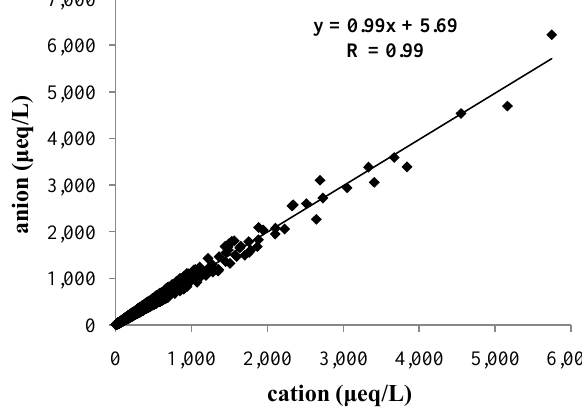
Fig. 3. Relationships between the sum of cations and that of anions.